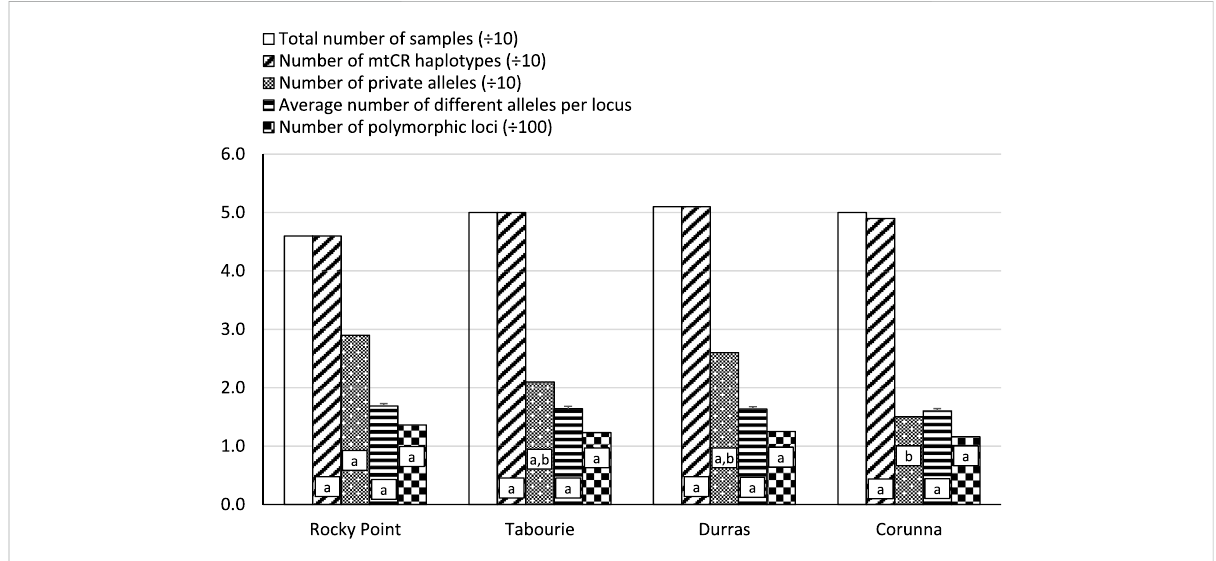
FIGURE 2 ThenumberofmtCRhaplotypesandallelicpatterndistributionamongfoureasternkingprawnpopulations.ThenumberofmtCRhaplotypesis the number of different/unique mtCR sequences found in a given population. The number of private alleles is the number of mtCR alleles (at a given nucleotide position)that occurredonly inone population and not in others. The average number of different alleles isthe number of different alleles at a given nucleotide loci, averaged over all nucleotide loci. The number of polymorphic loci is the number of nucleotide positions which were polymorphic(i.e.,thathadmorethanonenucleotidebase).Theanalyseswereconductedusingsamplescollectedbeforereleasefromeachsite,and samplesizeswerecloseto50for eachsite(Supplementary TableS1).NosamplesfromWallagootwereavailablebeforestocking.Barswiththesame letters are not signi fi cantly different form each other ( p > 0.05). For mtCR haplotype counts, number of private alleles and number of polymorphic